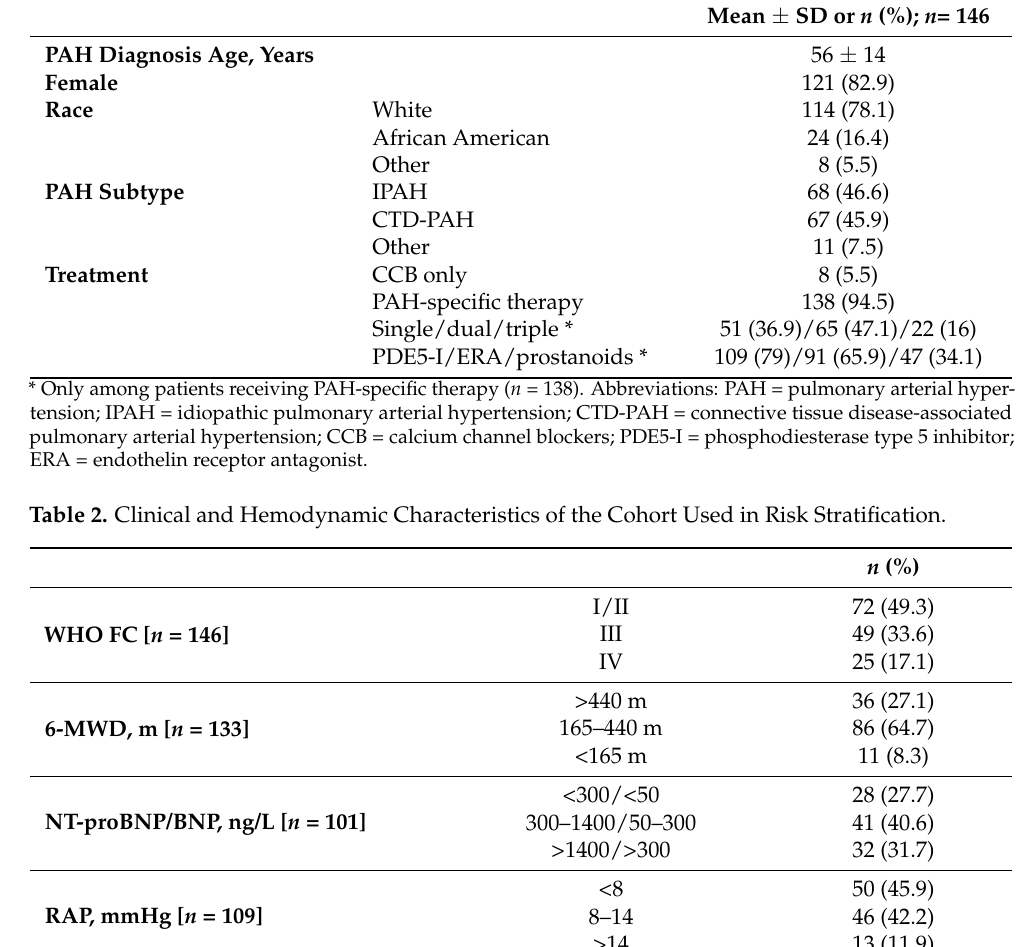
Table 1. Patients Characteristics.